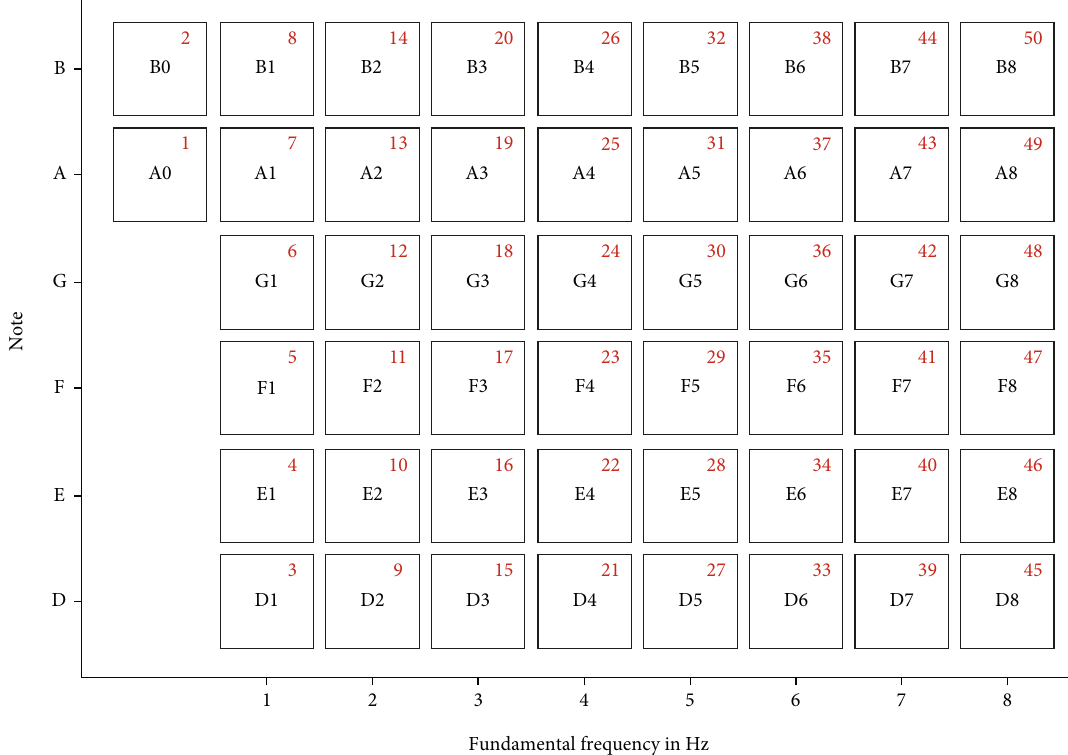
Figure 1: Notes ordered by pitch (frequency) on the ASAD